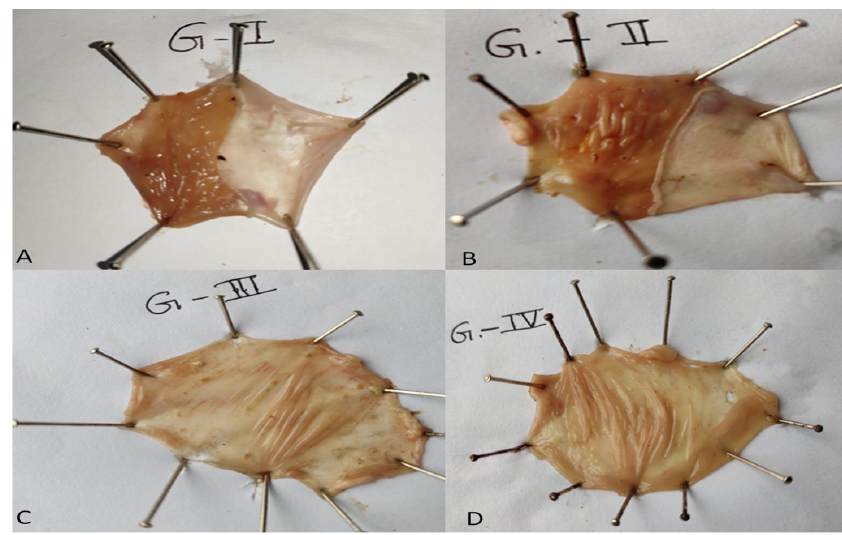
Figure 12. Photographs of ( A ) non ‐ ulcer induce stomach (Group ‐ I), ( B ) indomethacin induced (Group ‐ II), ( C ) Pure EZL (Group III) ( D ) EZL ‐ PNopt (Group IV). Table 5. Anti-ulcer activity of the EZL-PNopt formulation-treated group compared to other groups. Group Ulcer Index % Control